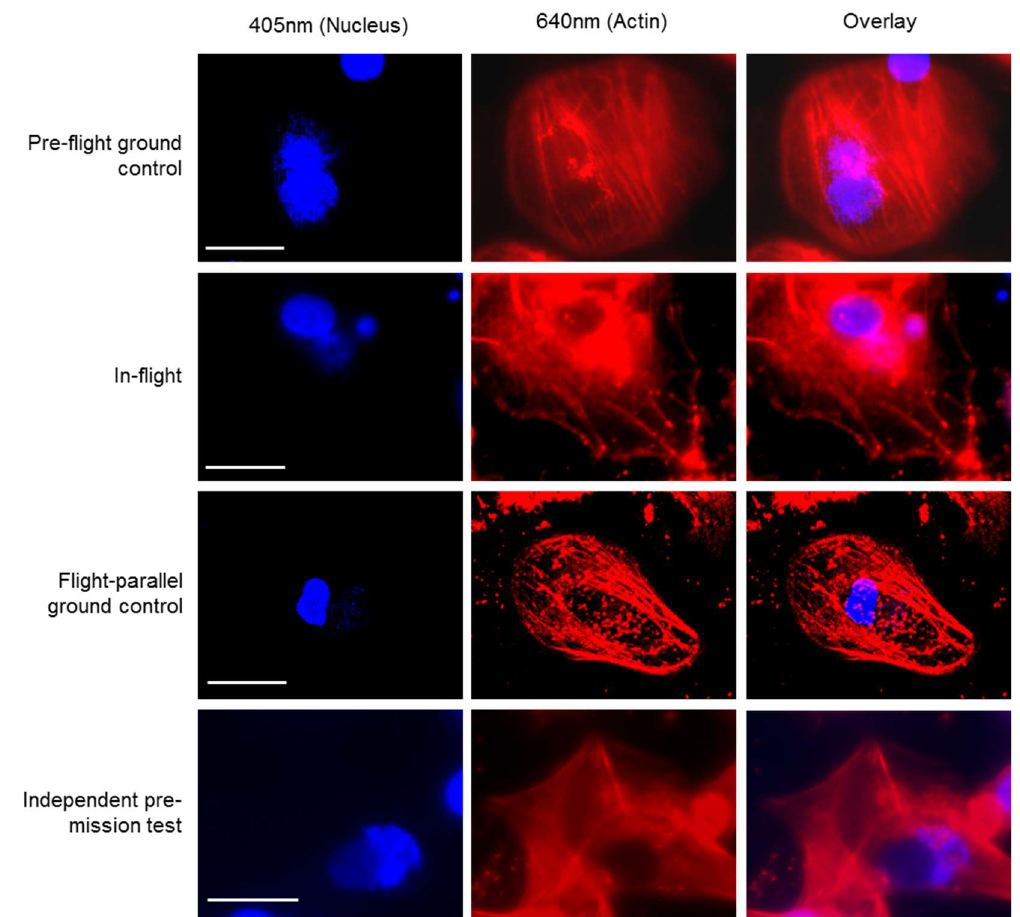
Figure 4. High-resolution fluorescence images of living primary human macrophages exposed to microgravity on the ISS. Cells were stained for nuclei (Nuclear Violet, blue) and actin (SiR-actin, red). Images were acquired on ground before upload to the ISS (Pre-flight ground control), and after 4 days of exposure to microgravity on the ISS (In-flight). Also shown are images from cells that were cultured in parallel to the in-flight samples (Flight-parallel ground control) as well as pictures of a pre-test of the FLUMIAS-DEA microscope (Independent pre-mission test). The “Flight-parallel ground control” group was acquired with a standard confocal microscope, while all other pictures were taken with the FLUMIAS-DEA microscope. Images show representative cells from the respective condition. Scale bars are 20 µm. For description of experiment sample groups see Table 4.